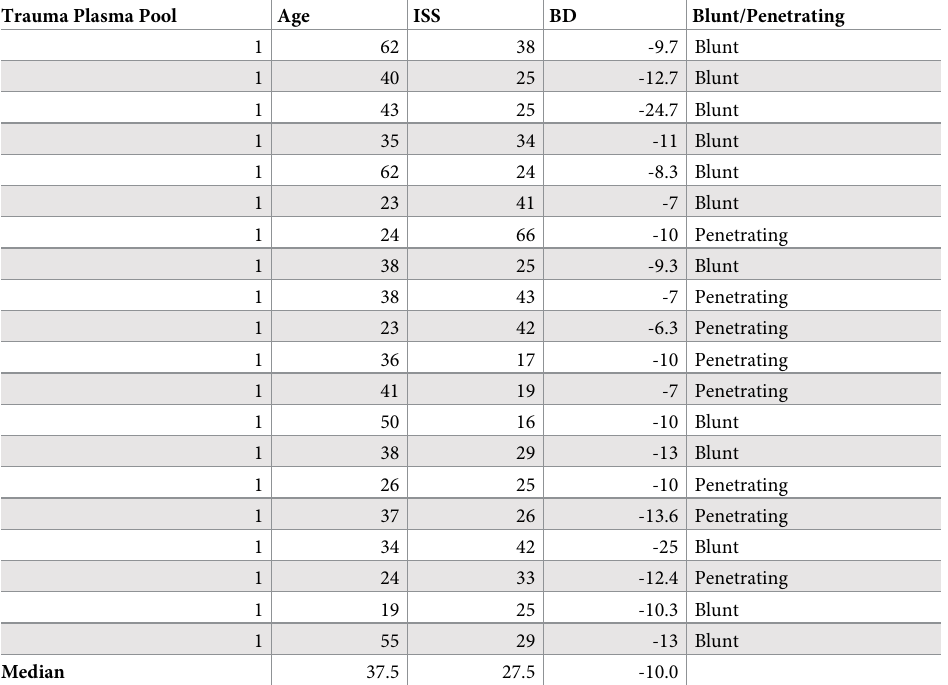
Table 1. Trauma plasma pool for transcription experiments described in Figs 1 and 2.